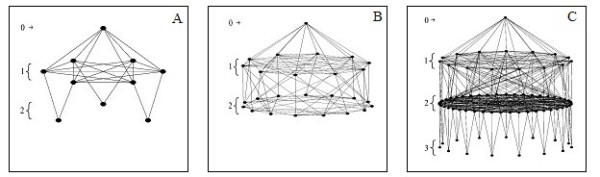
Three dimensional representation of the oxidative folding space of polypeptides with 4, 5 and 6 cysteine residues (A, B and C, respectively). The nodes represent intermediates, the number of disulfide bridges is indicated with numbers on the left of each panel. The edges indicate disulfide exchange transitions. Zero indicates the fully reduced state, nodes in the lowest plane are the fully oxidized intermediates, one of which is usually the native state. Edges within the same plane indicate shuffling reactions (interchange between two protein-bound disulfides), edges between planes are redox transitions in which a disulfide bridge is created or abolished. A simple visualization tool written for the Tulip package  can be obtained from V.A. vilagos@brc.hu